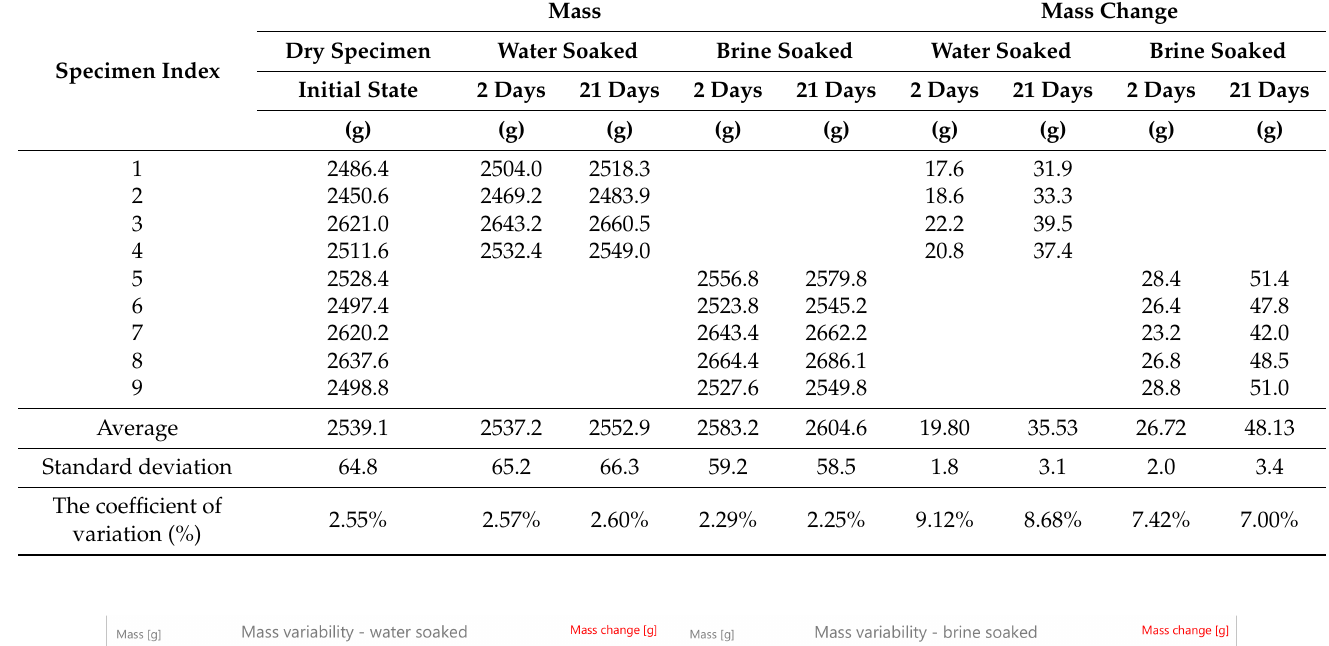
Table 11. Mass variability of MCE via soaking in water and brine.